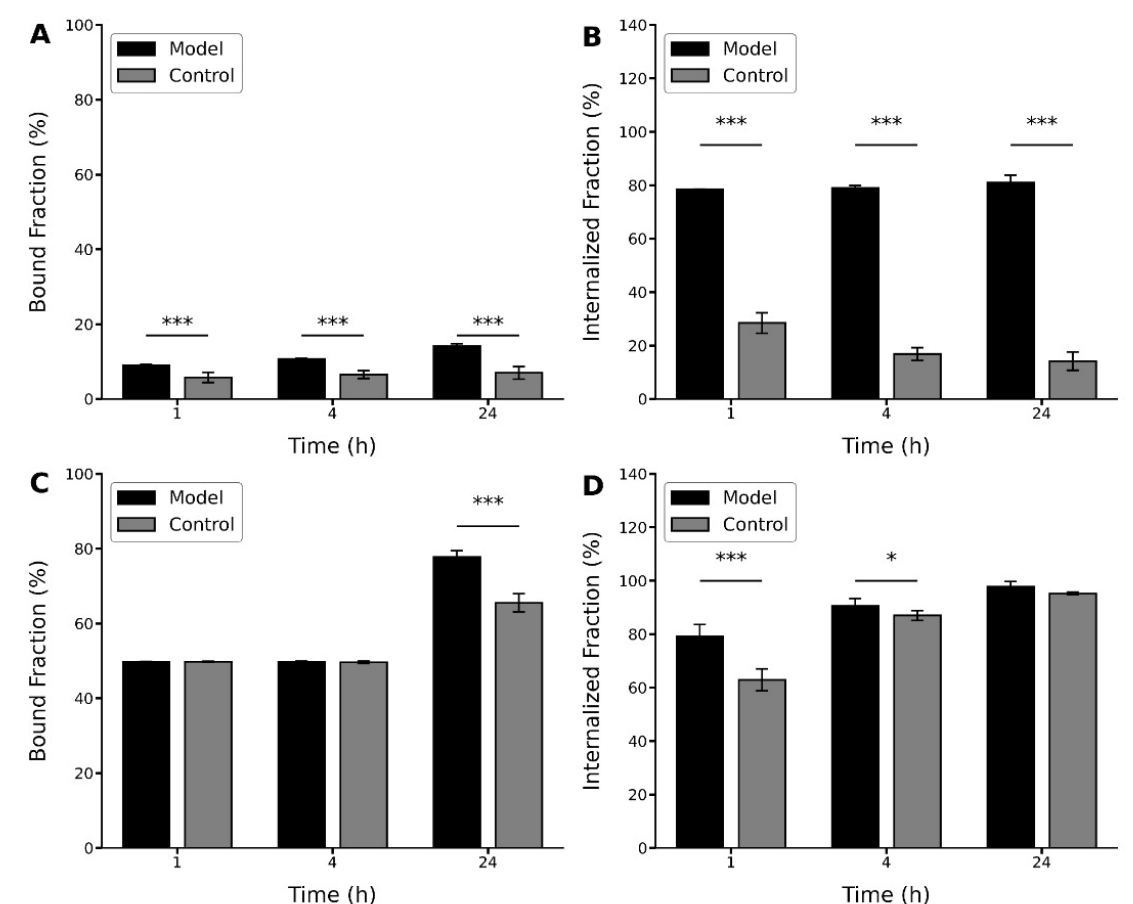
Figure 7. Bound and internalized fractions (%) of radiolabeled peptides in tumor-bearing glioblastoma brain homogenate (model) and normal (control) rats: ( A , B ) [ 131 I]I-GRGDYV and ( C , D ) [ 99m Tc]Tc(CO) 3 -GRGDHV. Data are expressed as ‘mean ± SD’. p < 0.001 (***) and p < 0.05 (*).